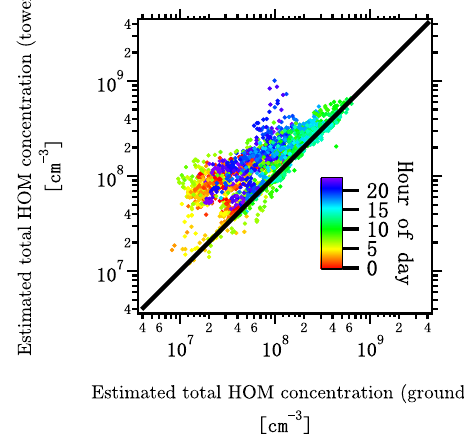
Figure 3. Comparison between ground ( x axis) and tower ( y axis) measurements of the estimated total HOM concentrations. The black line denotes the 1:1 ratio. Color code indicates the sampling time of HOMs.